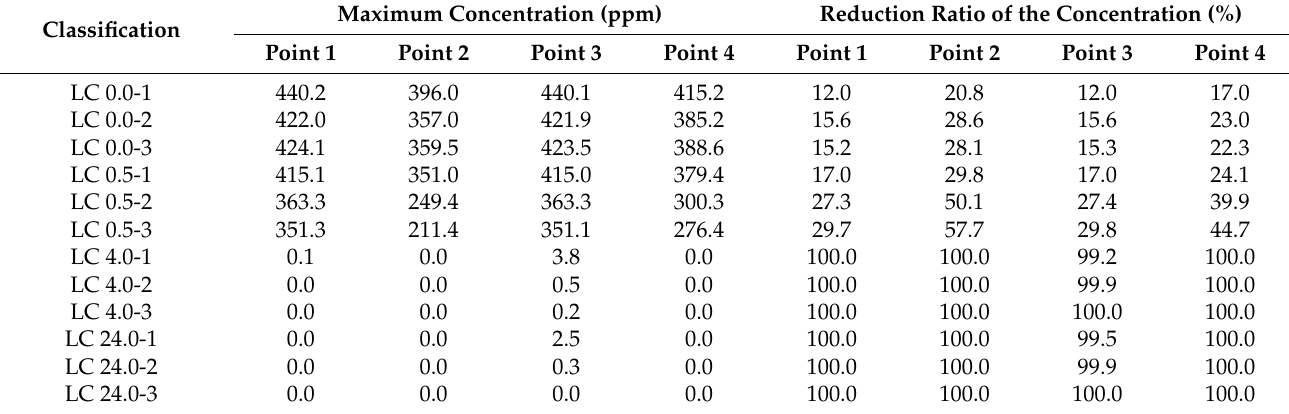
Table 7. FDA results for the low-TPH